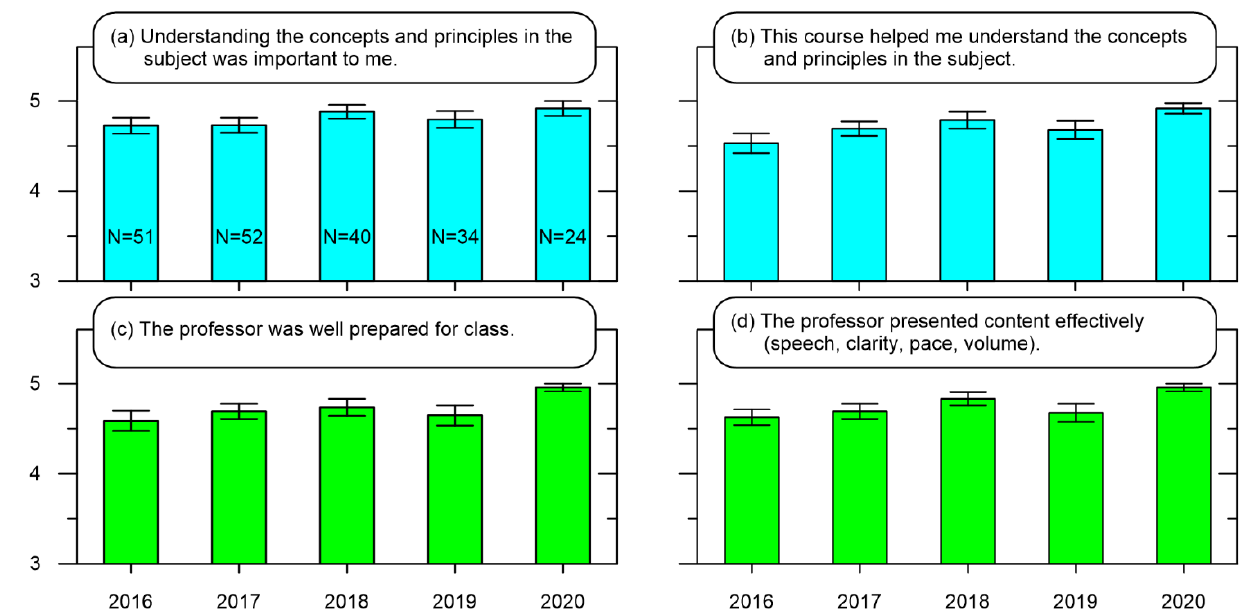
Figure 2. Compilation of course evaluation results for a 2020 second semester compulsory course at